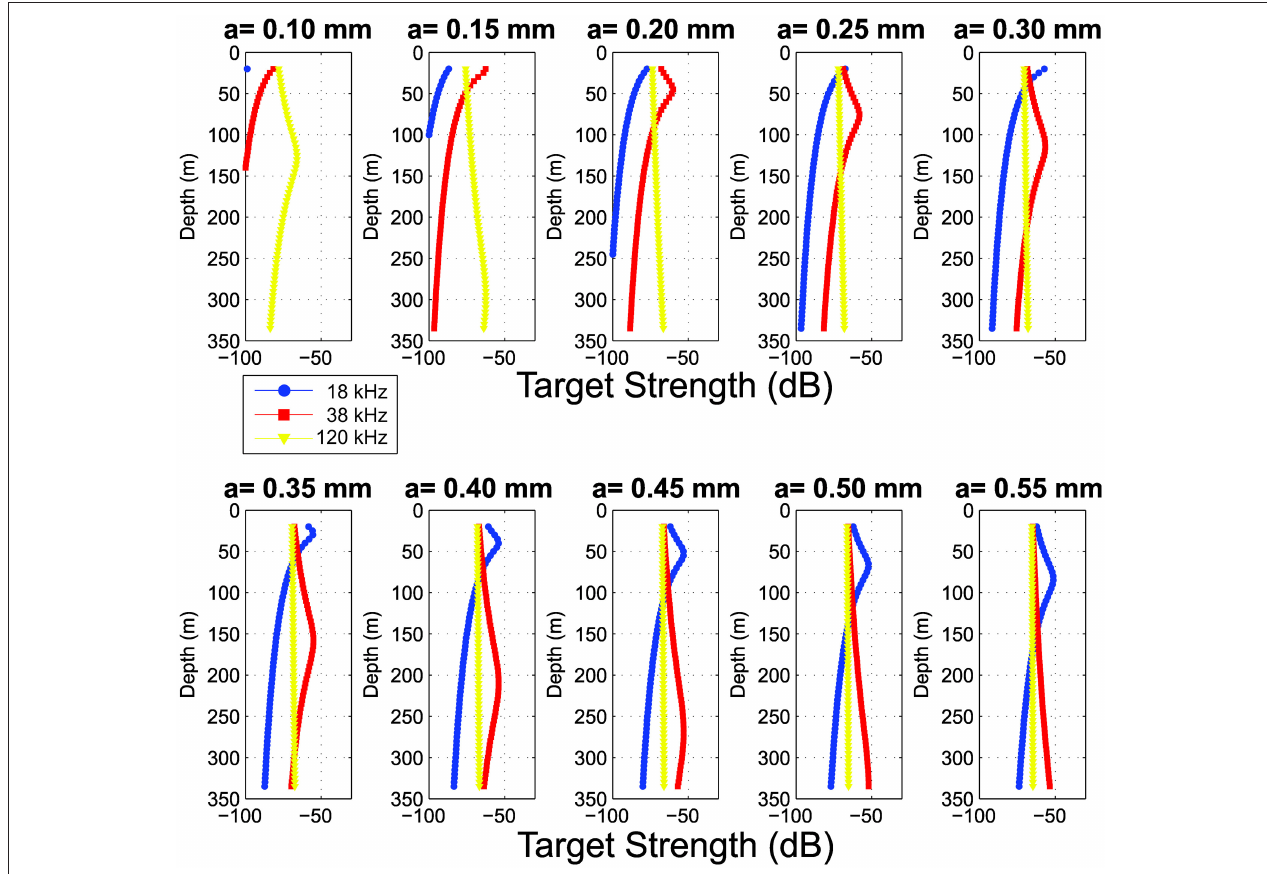
FIGURE 13 | Depth stratified estimated target strength, TS [dB re 1 m − 2 ] based on the hybrid damped model for siphonophore gas-inclusions with bubble radius (a) in the range 0.1 – 0.55mm in steps of 0.05mm.